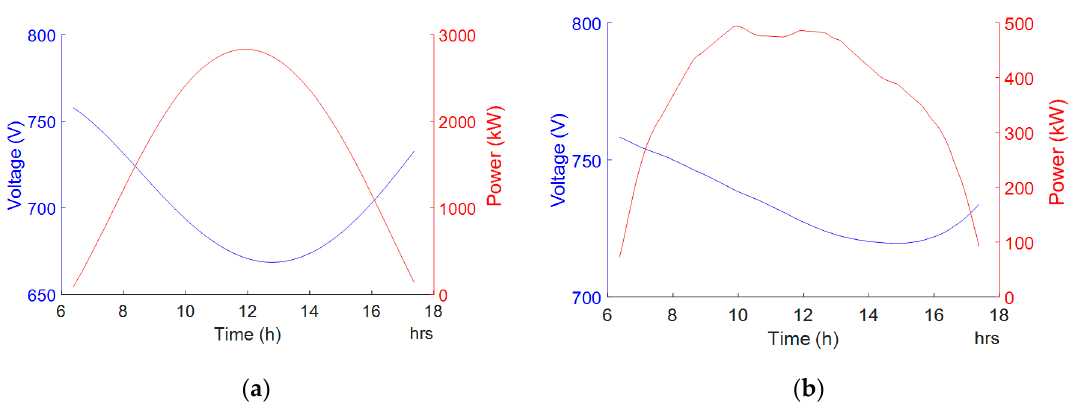
Figure 16. Daily power generation and MPPT voltage curves. ( a ) Sunny day. ( b ) Cloudy day.